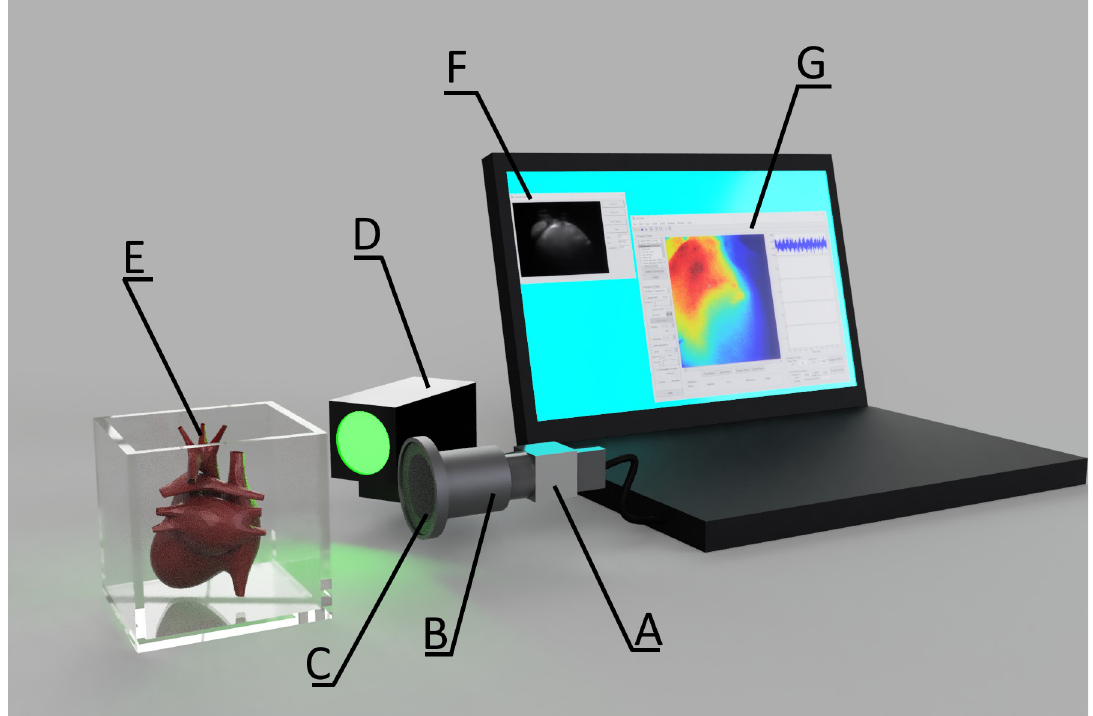
Fig 1. The experimental setup for the iDS camera. (A) iDS UI-3130CP M.GL camera (977Hz sampling frequency). (B) Pentax C60607KP lens. (C) 650nm long-pass filter. (D) Green excitation LED (530nm wavelength). (E) Perfusion chamber with heart. (F) iDS Recorder application. (G) Open source RHYTHM1.2 software, based on Matlab and C++.